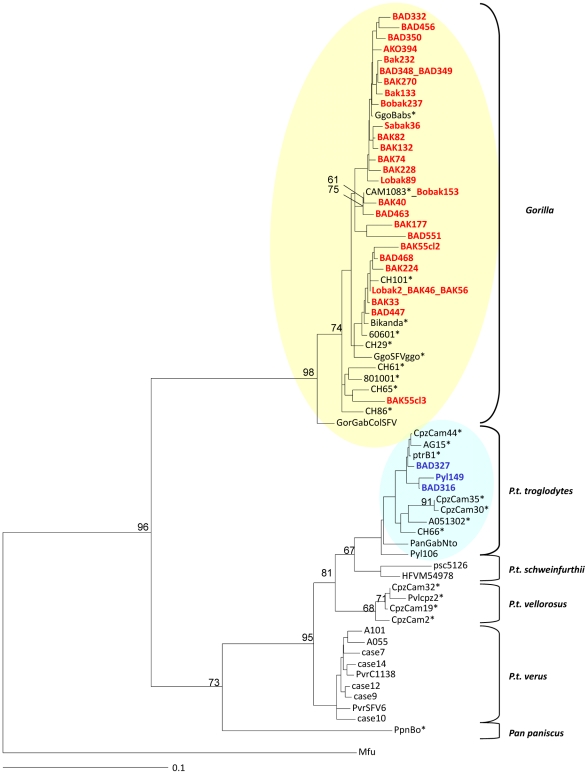
Rooted phylogenetic tree generated with consensus sequences of 425 bp fragments of the SFV pol-In from apes-infected hunters and prototype old world non-human primates from the apes' clades.The final consensus sequences from our study are highlighted in red (gorilla) and green (chimpanzee). Sequences are compared to known prototypes from different central African NHP species. Alignment was performed with Dambe version 4.5.68 and Clustal W. Phylogenetic analysis was performed with Paup, version 4.0b10 (Sinauer Associates, Sunderland, MA, USA) based on the Neighbour joining method applying the GTR model. Bootstrap analysis of 1000 replicates is indicated as numbers at nodes. Only values greater than 60% are shown. The scale of the tree is 0,1 nucleotide replacements per site. The tree is rooted on a divergent sequence from an Asian macaque. Species found in Cameroon are shown with asterisks. Sequences accession numbers are: JN049036 to JN049065 for gorilla sequences and JN049033 to JN049035 for Chimpanzee sequences.